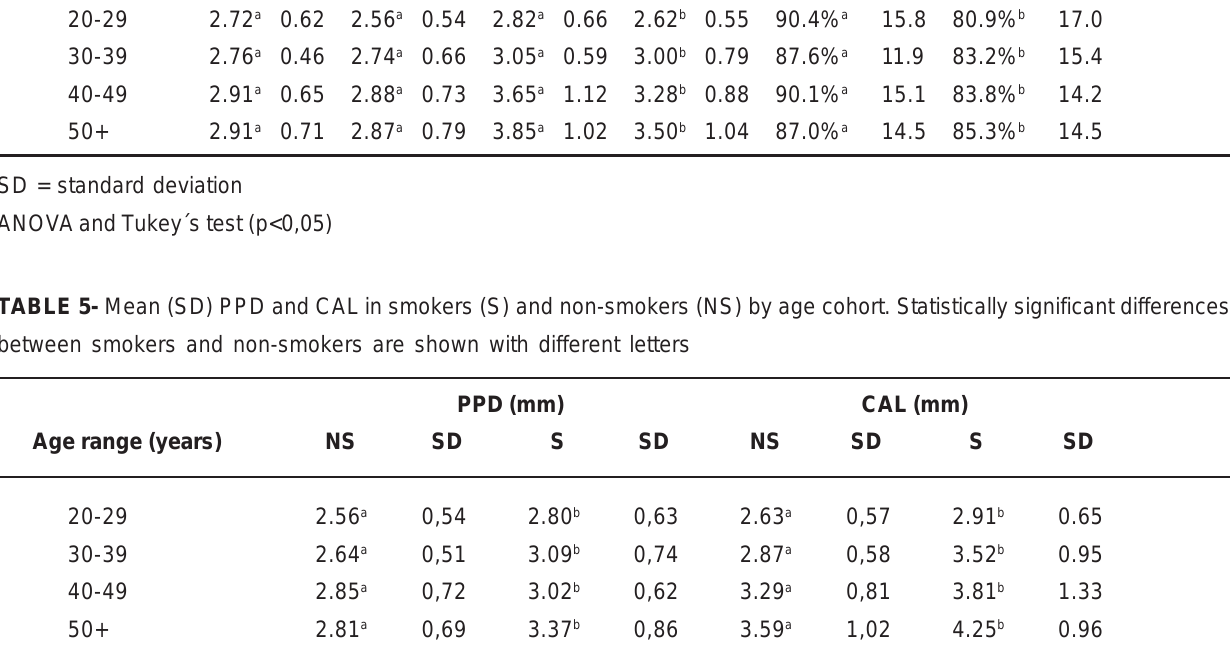
SD = Standard deviation ANOVA and Tukey´s test